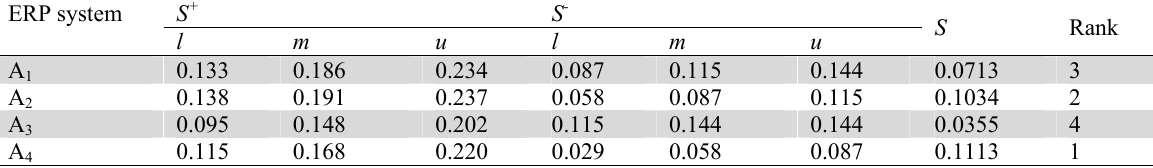
Ranking of ERP systems for example